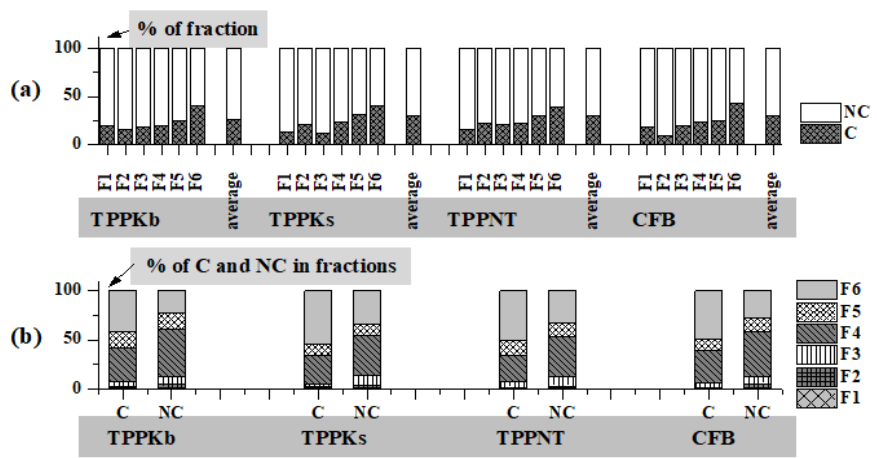
Figure 4. ( a ) Portions for carcinogenic (C) and non-carcinogenic elements (NC) and average values in each fraction for all fly ashes (TPPKb, TPPKs, TPPNT, and CFB); ( b ) overall distribution of C and NC elements among six fractions.